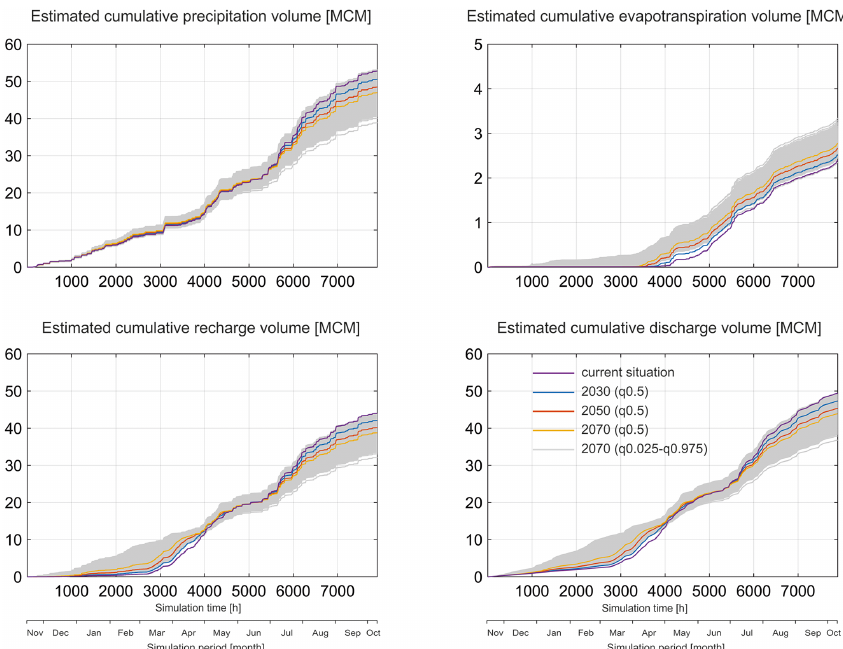
Figure 7. Impacts of the median climate scenarios ( q 0 . 5) for years 2030, 2050 and 2070 as well as the uncertain climate scenarios (1000 random sampled combinations) for 2070 on the simulated precipitation, evapotranspiration, recharge and discharge for the studied catchment.